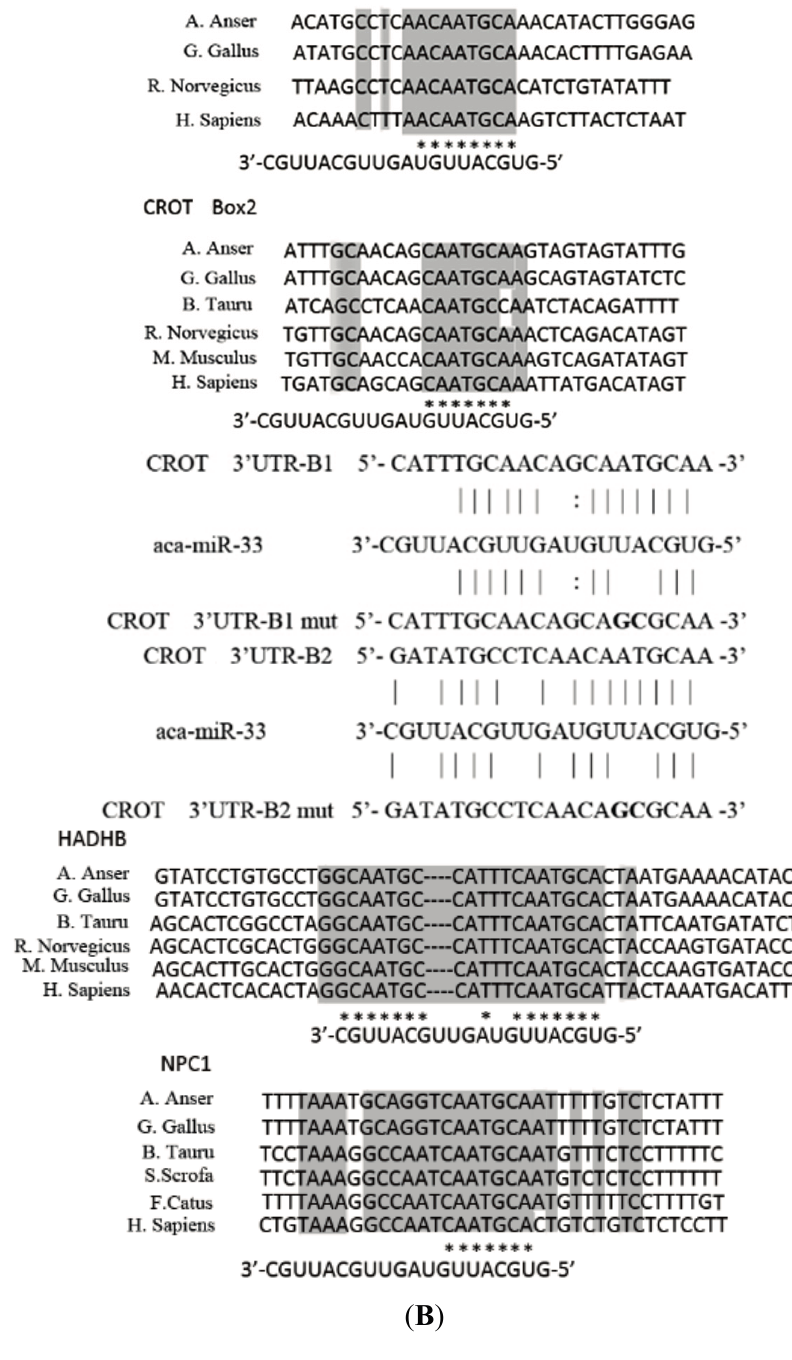
Figure 3. Target binding sites of the miR-33 target gene. ( A ) Complementary situation of miRNA-33 and the target gene loci. Vertical lines represent the complete complement of the genes to one another; “:” represents the GU complement; and the bolded section indicates the bases for mutation. In HADHB , the site that is near the 3 ′ end is target Site 1, and the site near the 5 ′ end is target Site 2; “aca” represents the geese; “mut” represents the mutation site of target genes; ( B ) Homology in different species of target gene loci. The sequence of the gray area is constant. * The complement base. ( H. Sapiens , human; A. Anser , goose; G. Gallus , chicken; B. Tauru , cow; S. Scrofa , pig; F. Catus , cat; R. Norvegicus , rat; and M. Musculus ,